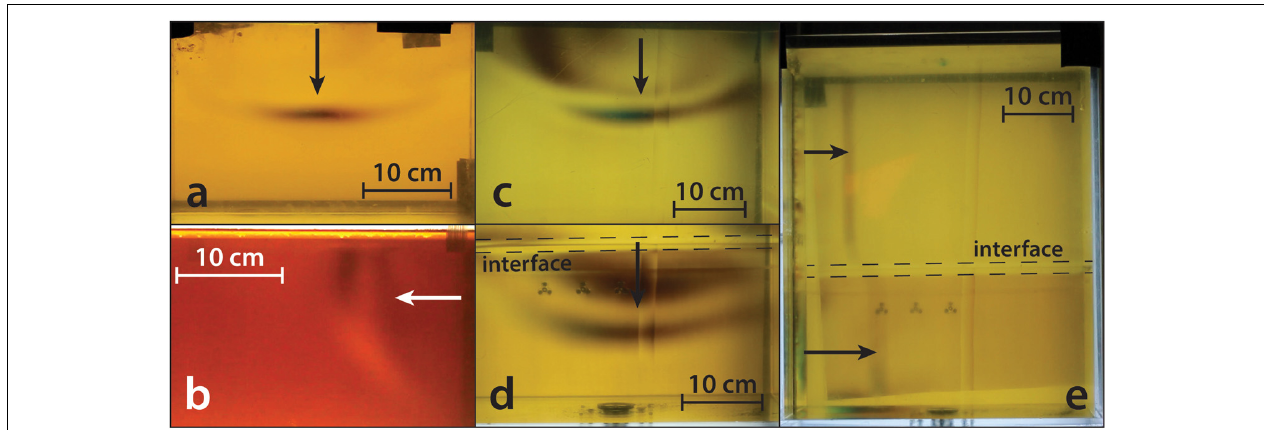
FIGURE 2 | Waves are generated in different directions by strike a small block, placed on the surface, perpendicular to that direction. All images are side views of the experiments. (a,b) Representing vertical and horizontal propagation in a homogenous block (respectively, experiments Ex7 and Ex8 in Table 1 ). (c,d) Vertical propagation in two different layers (experiments L3a and L3b). The welded interface zone is indicated by the black dashed lines. (e) A broad, horizontally propagating wave in the same gelatin as (c,d) . The wave separates due to the strength contrast between the layers. The welded zone shows a smooth velocity transition between the